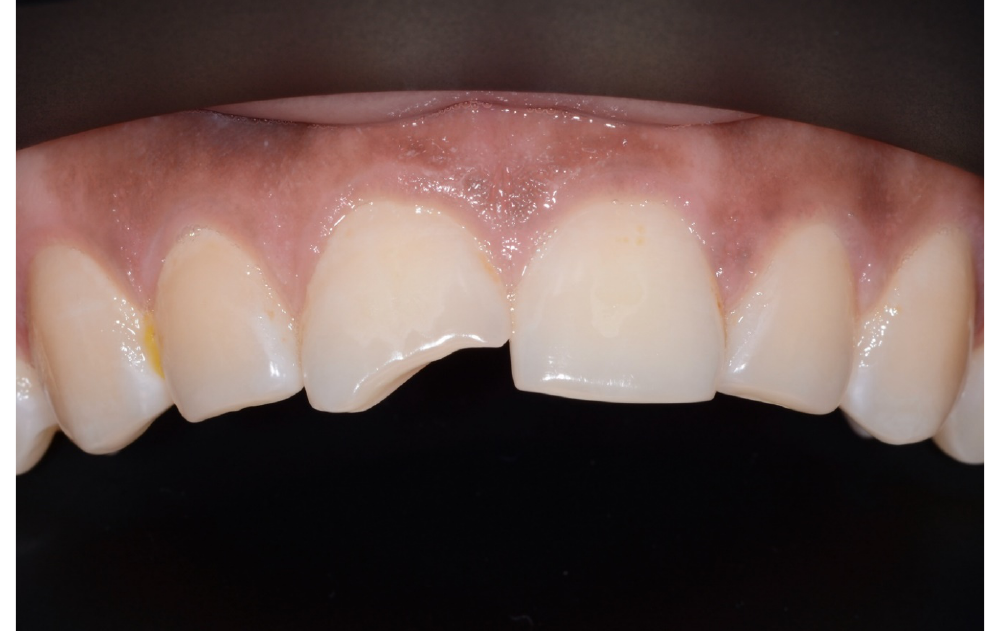
Figure 1. Initial situation, enamel-dentine fracture of tooth 11 of an autism spectrum disorder (ASD) patient. (©Max Diekamp).